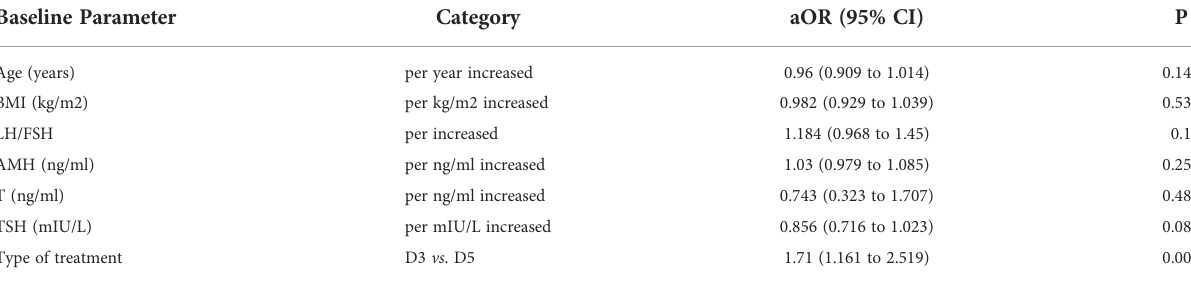
TABLE 5 Logistic Regression of Conception Outcome.